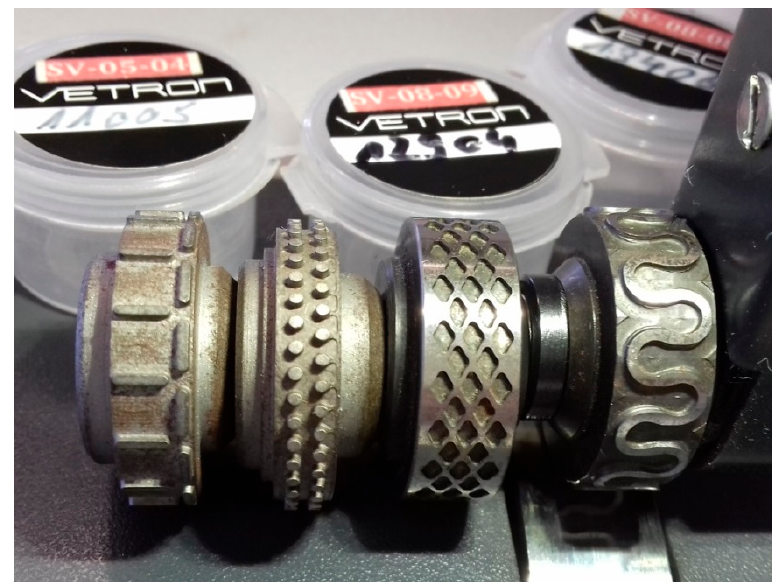
Figure 1. Anvil wheels chosen for this study. From left to right: T-stitch, point 2-rowed, diamond, and omega.